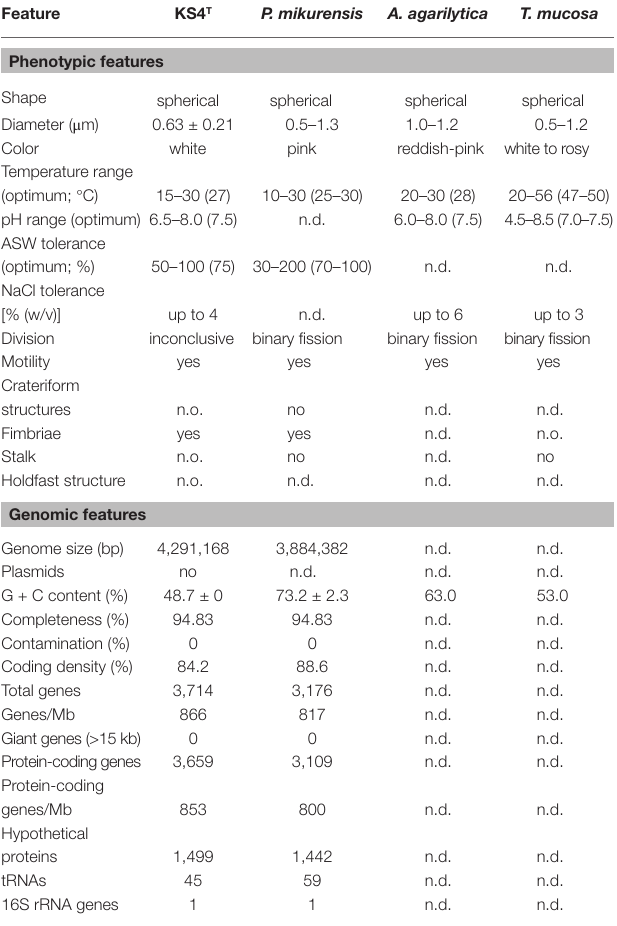
TABLE 1 | Phenotypic and genotypic features of strain KS4 T compared to closely related strains in the class Phycisphaerae . Feature KS4